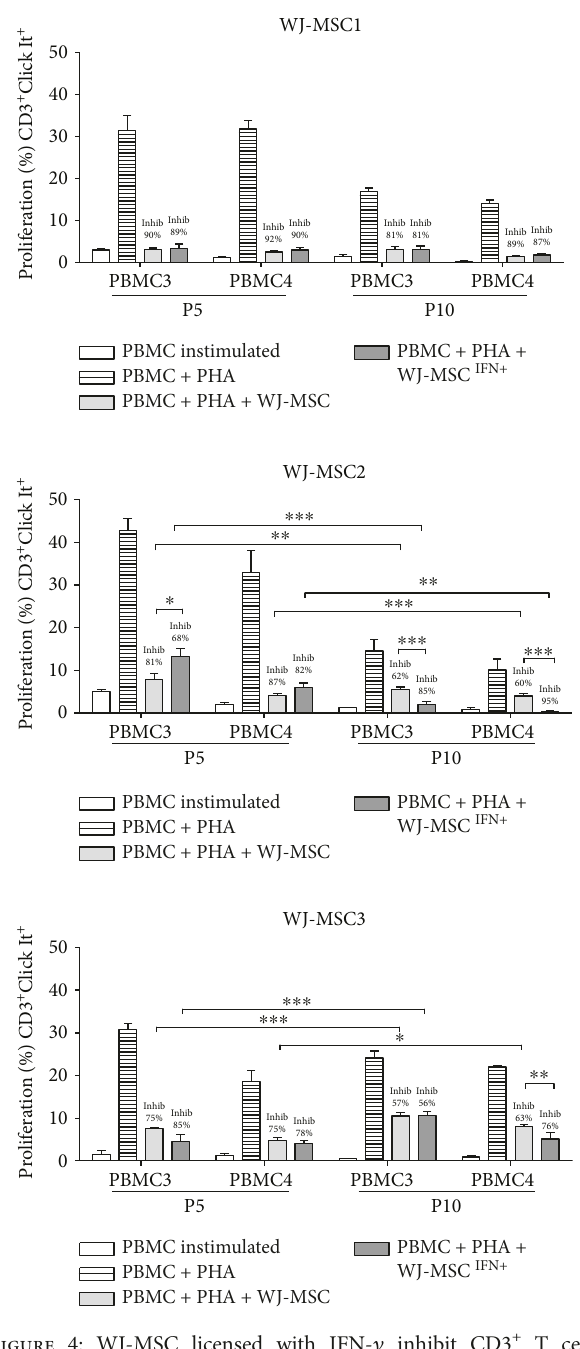
Figure 4: WJ-MSC licensed with IFN- γ inhibit CD3 + T cell proliferation. WJ-MSC were seeded, and IFN- γ was added for 24 hours. PBMC were stimulated with PHA for 3 days in the presence of WJ-MSC; the ratio used was 1 :10 (WJ-MSC : PBMC). The WJ-MSC passages used in the experiments were P5 and P10. T cells were collected, stained with anti-CD3, anti-CD4, and anti- CD8 antibodies, and proliferation was measured by fl ow cytometry using the Click It Kit. The percentage of inhibition (Inhib) was calculated using the percentage of proliferation of PBMC + PHA+ WJ-MSC compared to the control PBMC + PHA. Experiments were performed in triplicate. Results are represented by mean ± SD. Statistically signi fi cant di ff erences are shown as ∗ p < 0 05 , ∗∗ p < 0 005 , and ∗∗∗ p < 0 0001 ( n = 3